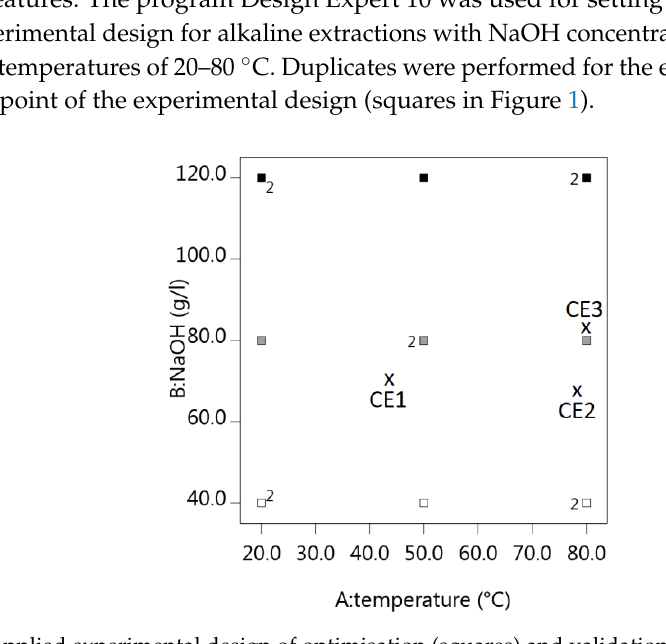
Figure 1. Applied experimental design of optimisation (squares) and validation experiments (crosses).